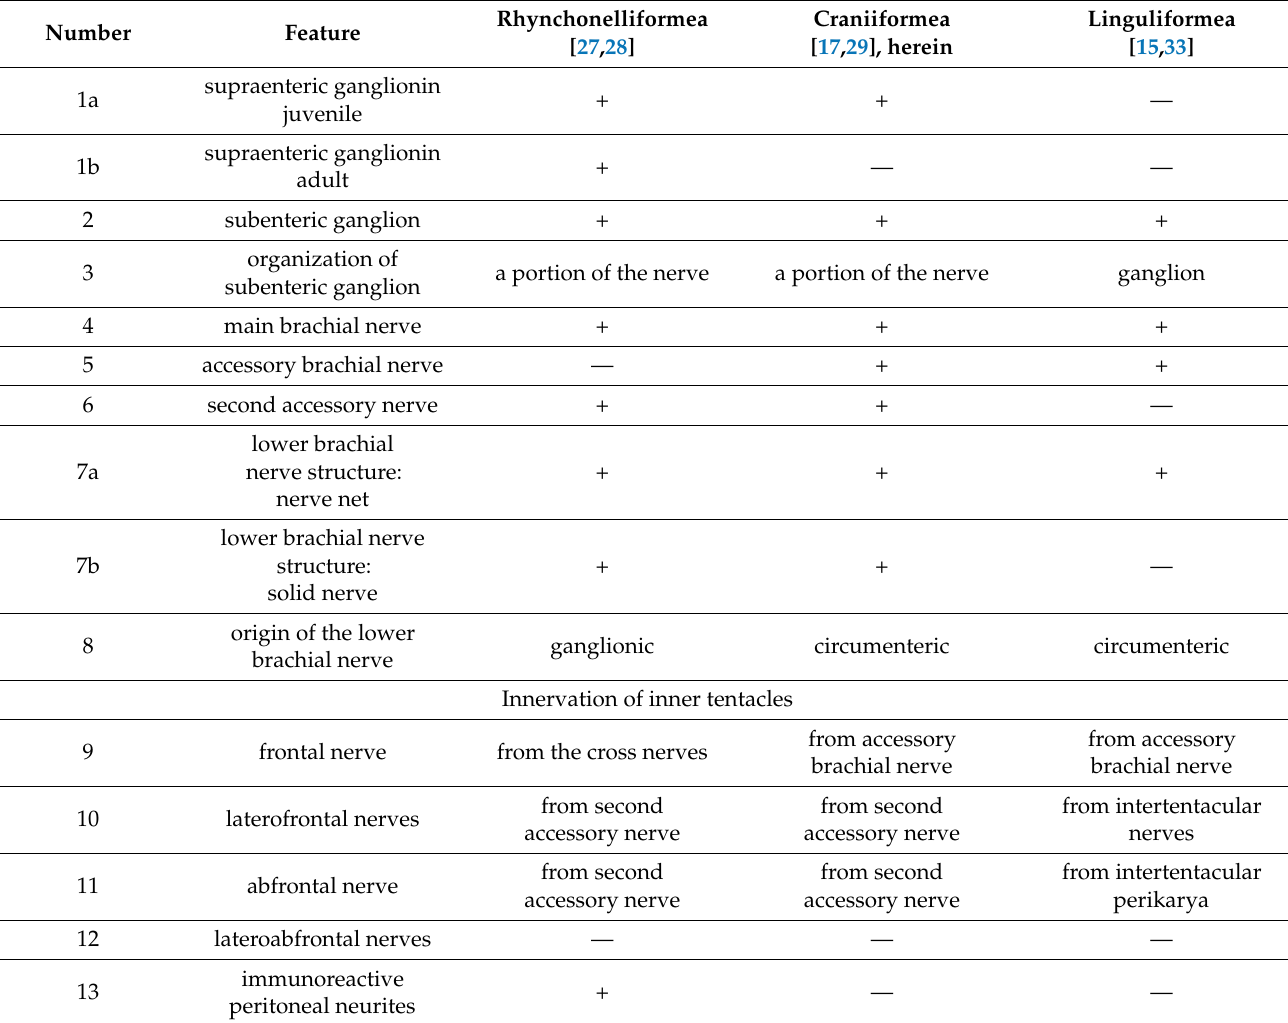
Table 1. Nerve elements of the lophophore in the three subphyla of